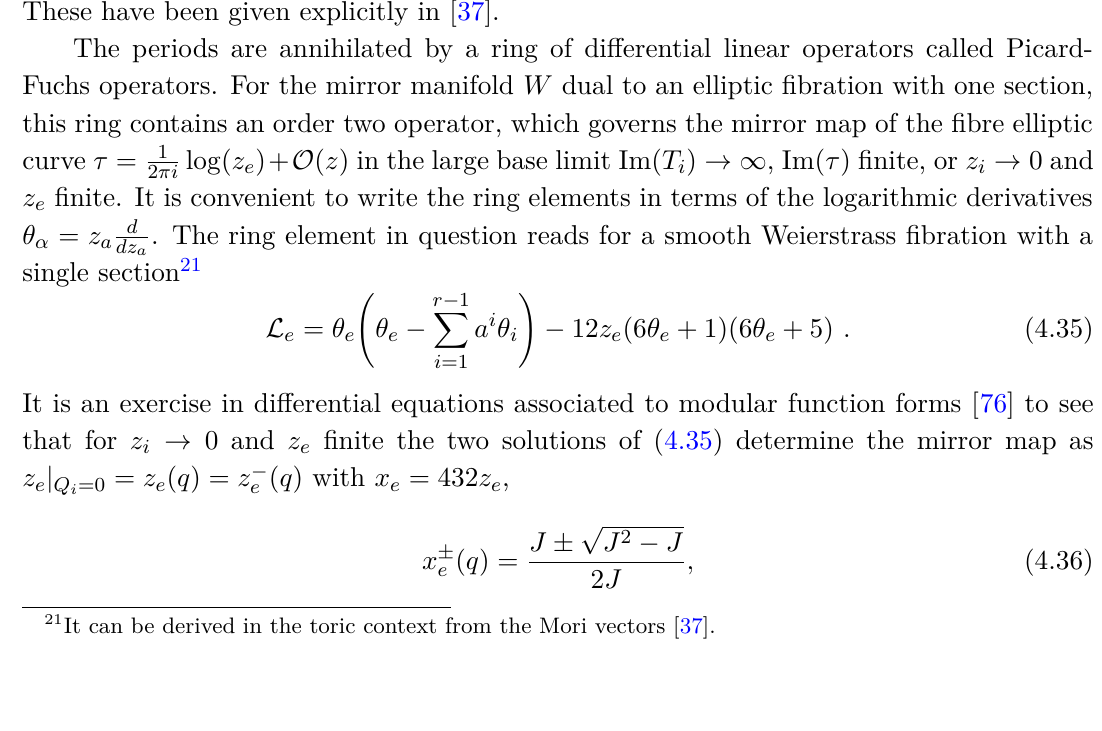
Figure 2 . The general moduli of the elliptic fibration. The moduli space of the local model, which arises for large elliptic fibre, is represented by the vertical red planes at x are two equivalent planes exchanged by the involution symmetry. There are two large radius points at the intersection of the common vanishing of the coordinates for the local model { x describe the large Kähler volume of the base. These are represented by the horizontal line with the vertical x = 0 , 1 e